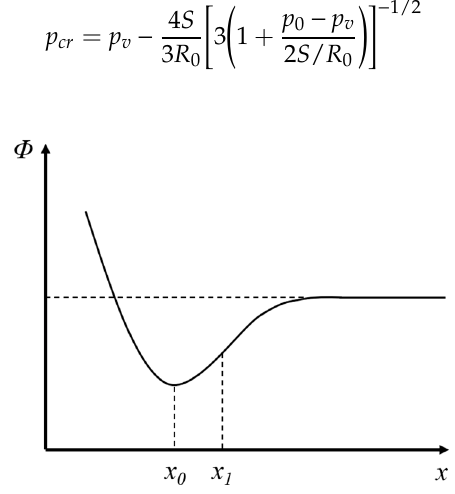
Figure 6. Intermolecular potential versus distance, x , between molecules [28].